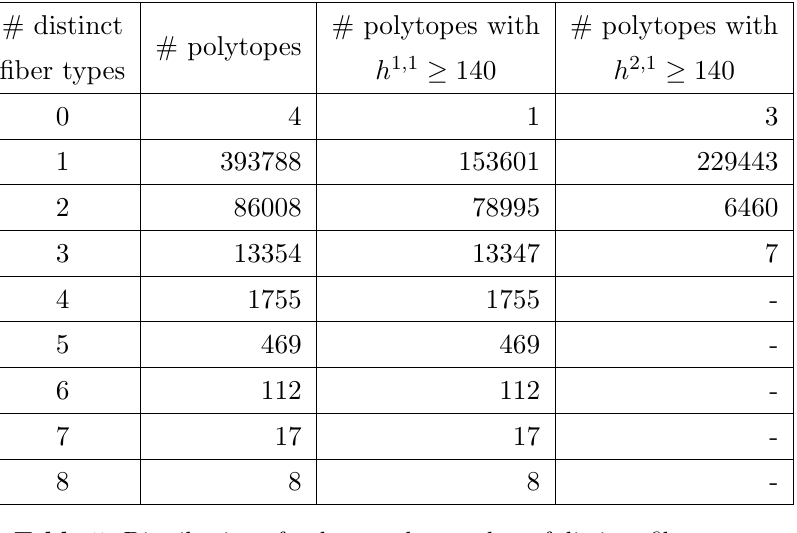
Table 5 . Distribution of polytopes by number of distinct (cid:12)ber types